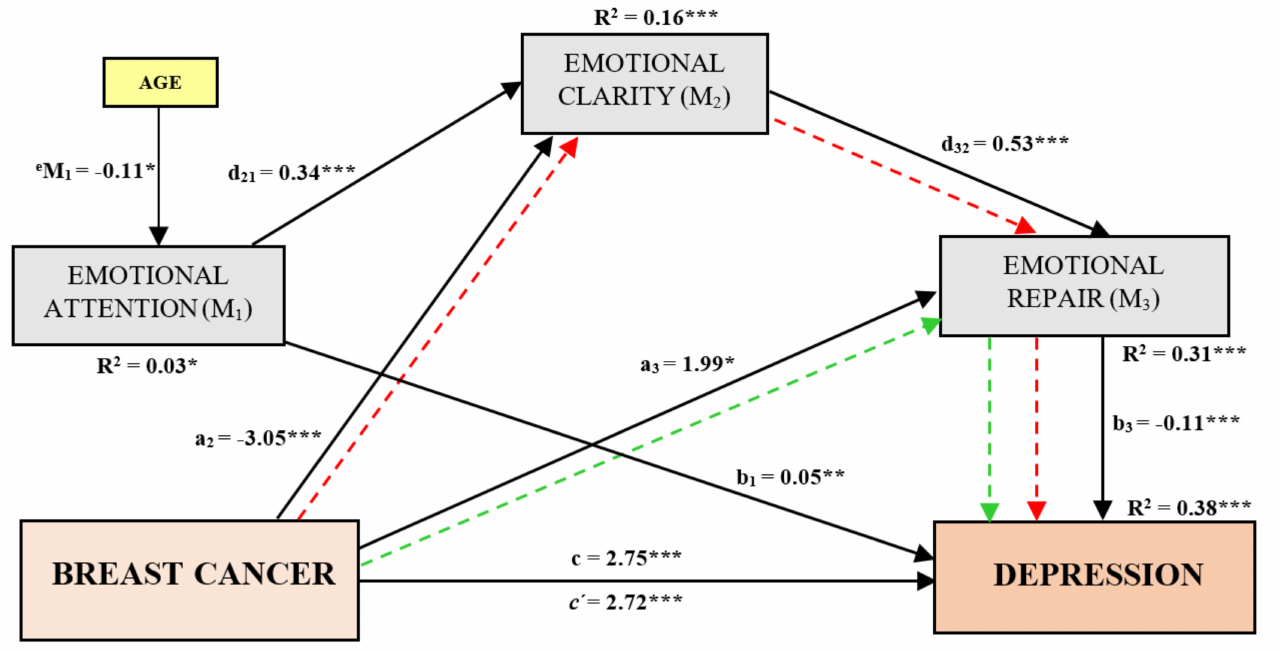
Figure 1. Direct and indirect effects for the proposed Serial Multiple Mediation Model. Notes: